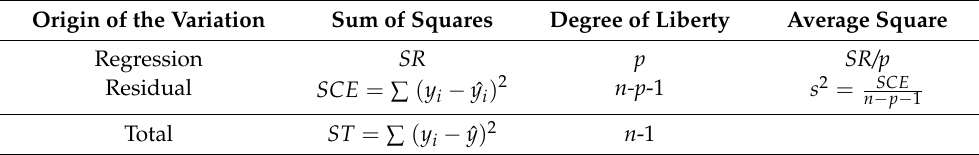
Table 2. Analysis of variance.